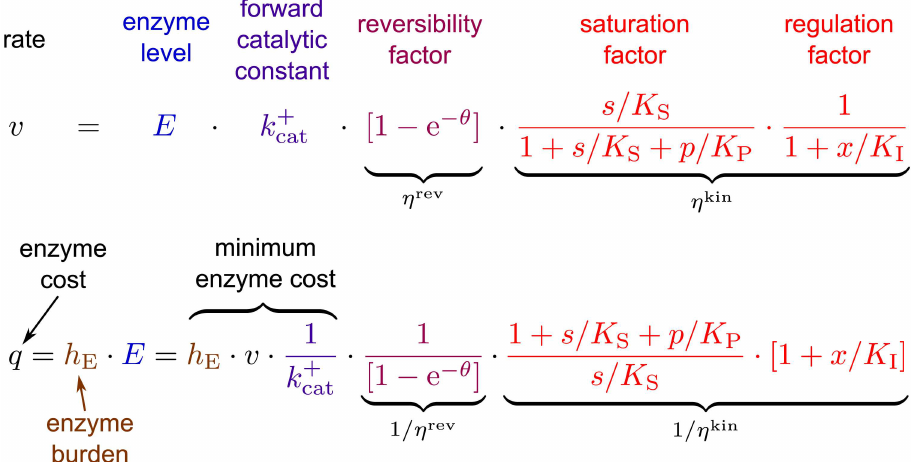
Fig 6. Rate law and enzyme demand of reversible Meichalis-Menten reactions. For a reaction S Ð P with reversibleMichaelis-Menten kinetics, a driving force θ = −Δ r G 0 / RT , and a prefactor for non-competitive allostericinhibition,the rate law can be written as with inhibitor concentration x . In the example, with non- competitive allostericinhibition,the kinetic factor η kin could even be split into a product η sat (cid:1) η reg . The first two terms in our example, E (cid:1) k þ , represent the maximal velocity (the rate at full substrate-saturation, no cat backward flux, full allostericactivation), while the followingfactors decrease this velocity for different reasons: the factor η rev describes a decrease due to backward fluxes (see Figure A in S1 Text) and the factor η kin describesa further decrease due to incomplete substrate saturation and allostericregulation(see